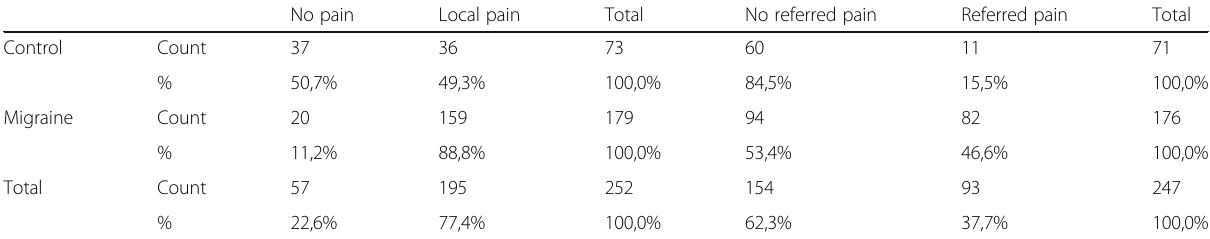
Table 2 Contingency table for local pain provocation and referred pain in migraine patients and